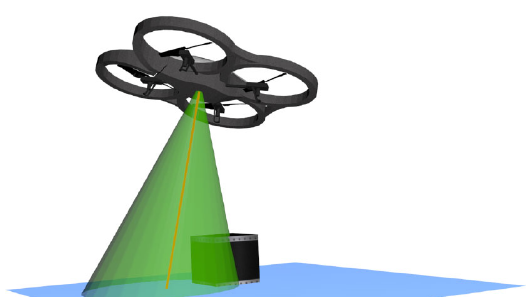
Figure 2. Overview of the ultrasound sensor cone: the green cone indicates the range of the ultrasound sensor [7].